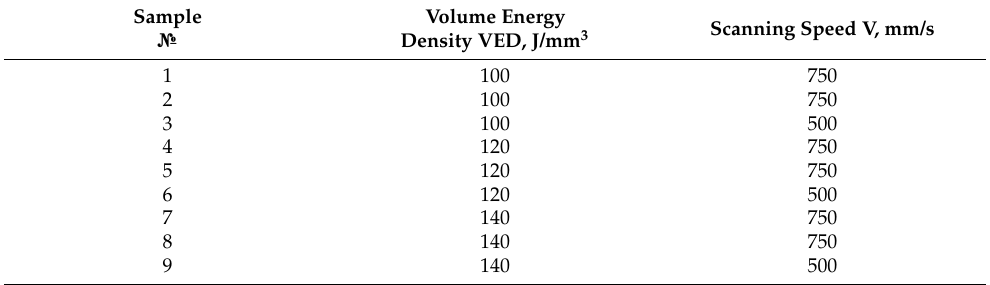
Table 5. The experiment plan 2 2 × 3.